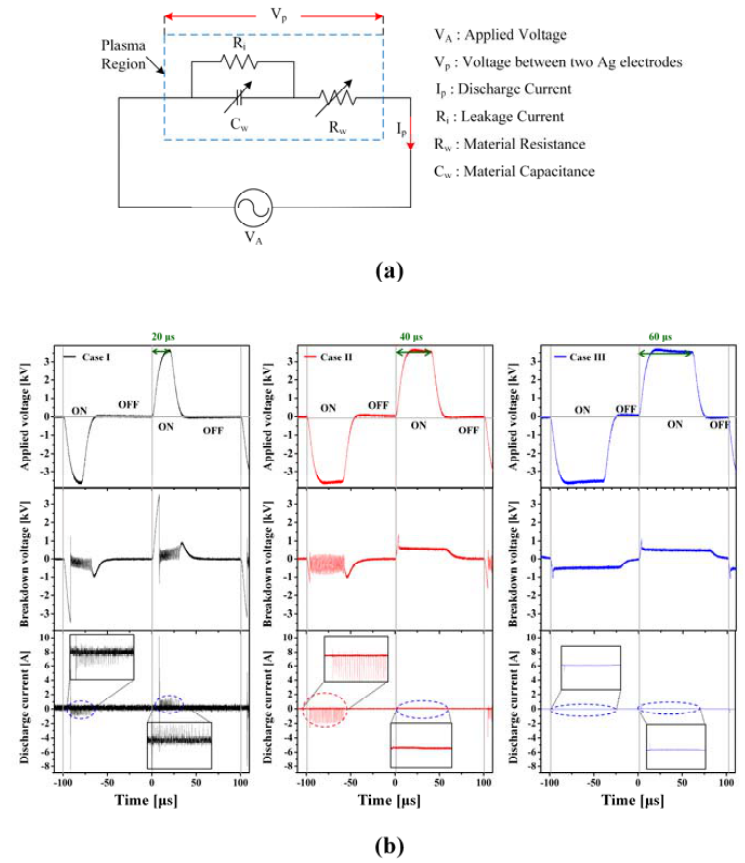
Figure 3. ( a ) Electrical model of liquid plasma region and ( b ) three voltage waveforms with related breakdown voltages and discharge currents (V p -I p ) measured during one cycle with different on-times; 20 µ s for case I, 40 µ s for case II, and 60 µ s for case III.